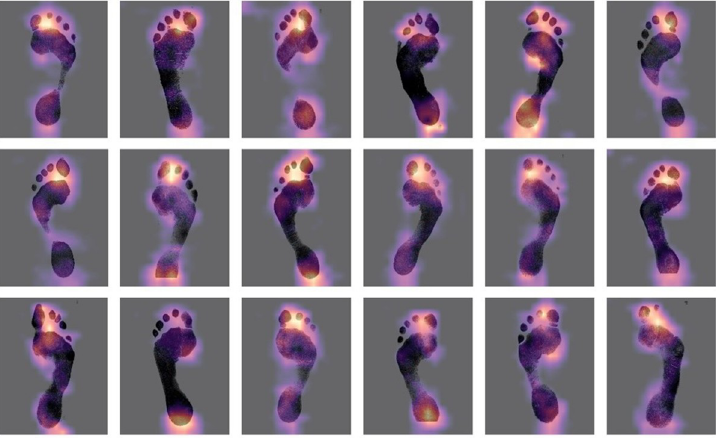
Fig 6. Grad-CAM heatmaps for textured inputs with the lowest entropy losses. The heat maps indicate areas which a key in the decision-making process. Note the concentration of bright areas around the heel and just behind the first and second